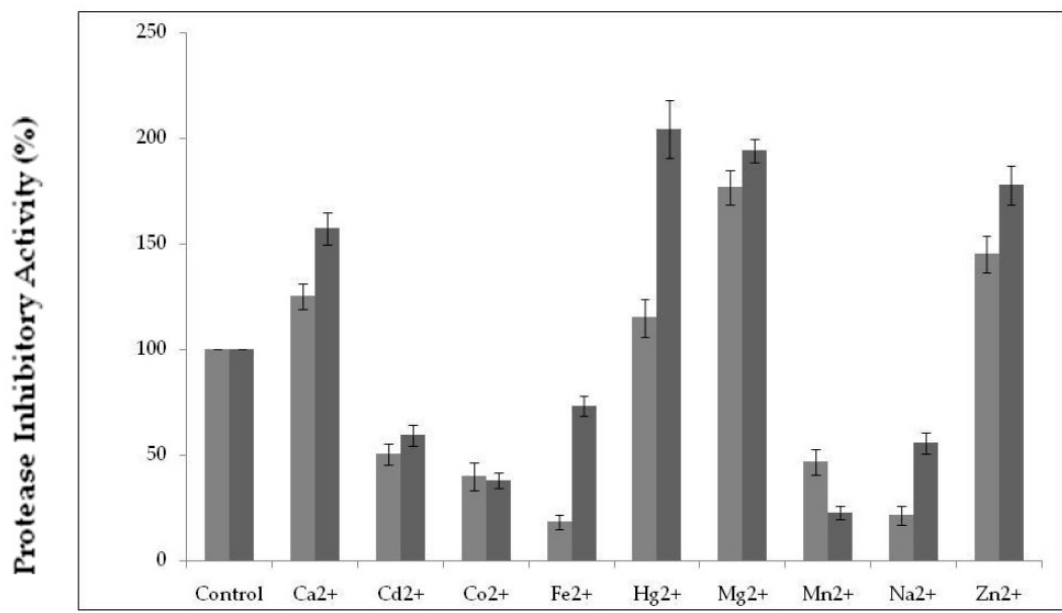
Figure 5. Effects of metal ions at different concentrations on PDInhibitor activity. The protease inhibitor assay was performed at 37 °C and pH 7. The control represents 100% of the protease inhibitor activity under the same conditions in the absence of any metal. The data shown are the mean ± SD ( n = 3).